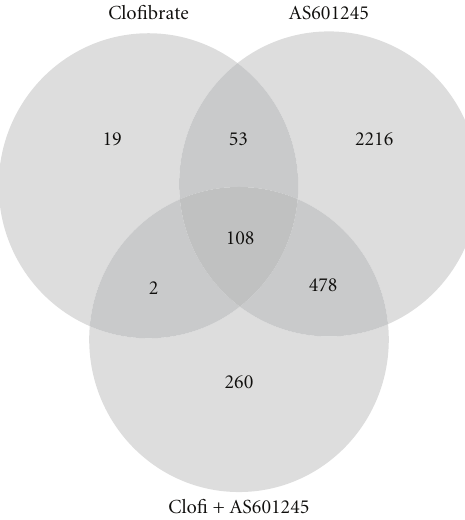
Figure 5: Microarray analysis of gene expression. Venn diagram derived from microarray analysis of gene expression in CaCo-2 cells treated with 5 μ M clofibrate, 0.1 μ M AS601245, and the association of these two compounds (Clofi + AS601245) at 24 hours. The diagram shows the number of genes modulated by the